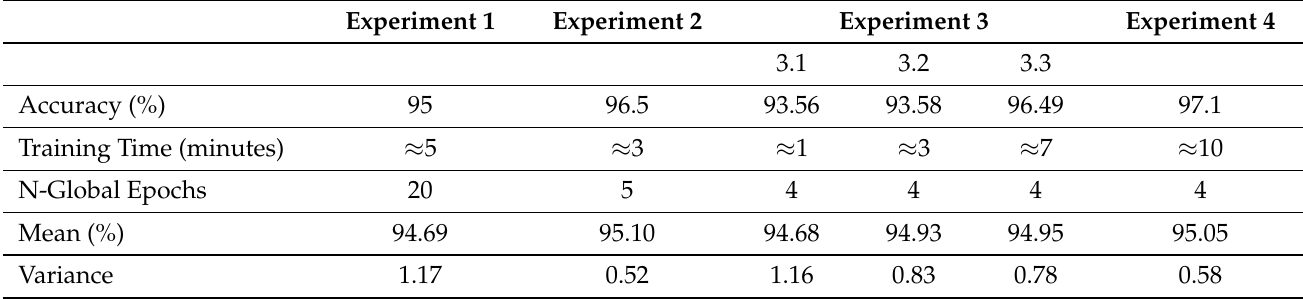
Table 1. Comparison table of experiment